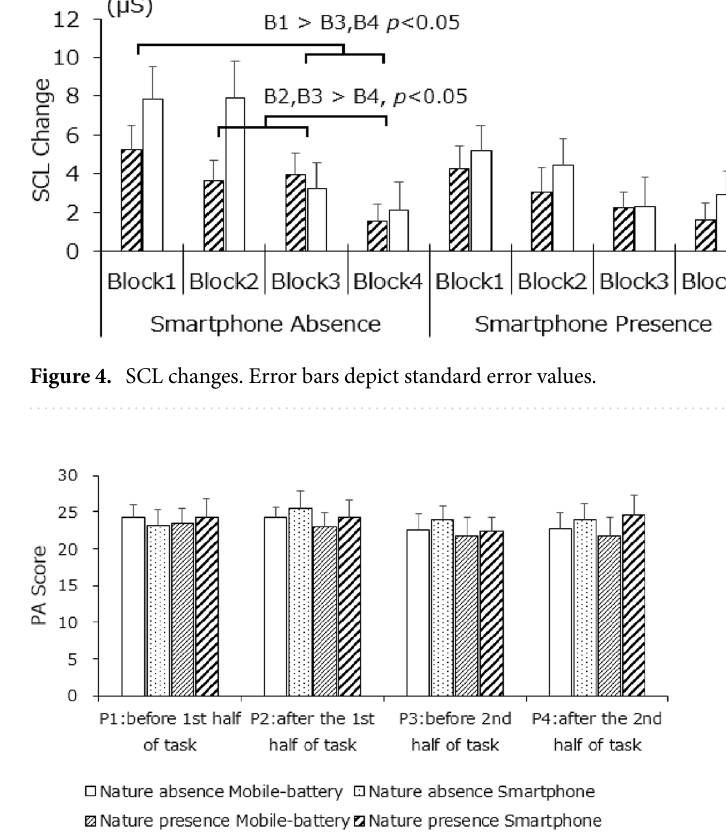
Figure 5. Mean positive affect scores. Error bars depict standard error